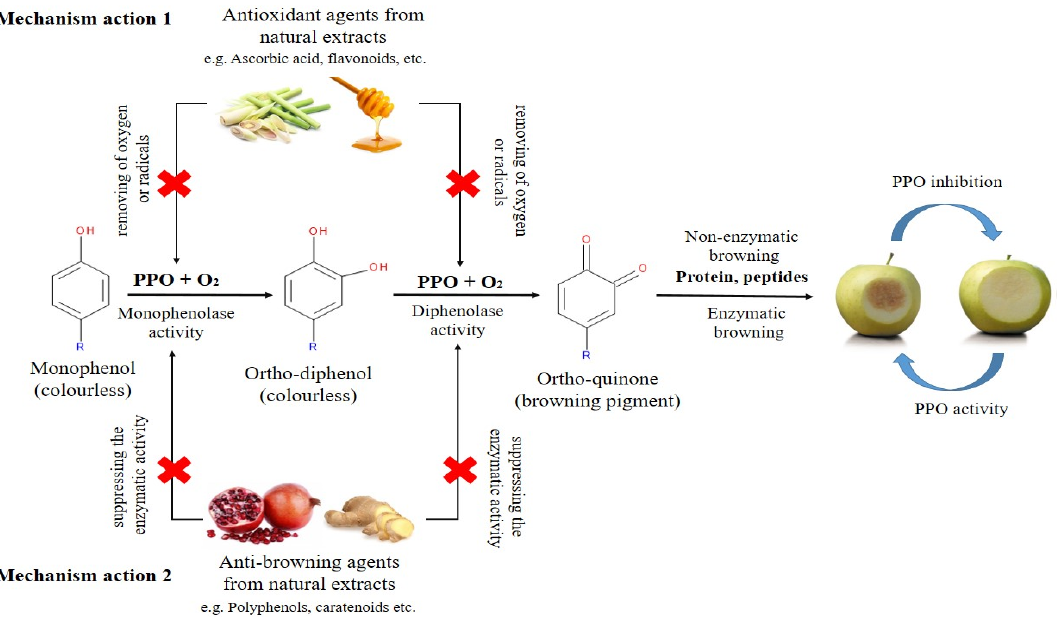
Figure 5. The schematic of enzymatic browning process and inhibition mechanisms of natural extracts. The figure was modified from Moon et al. [3] .